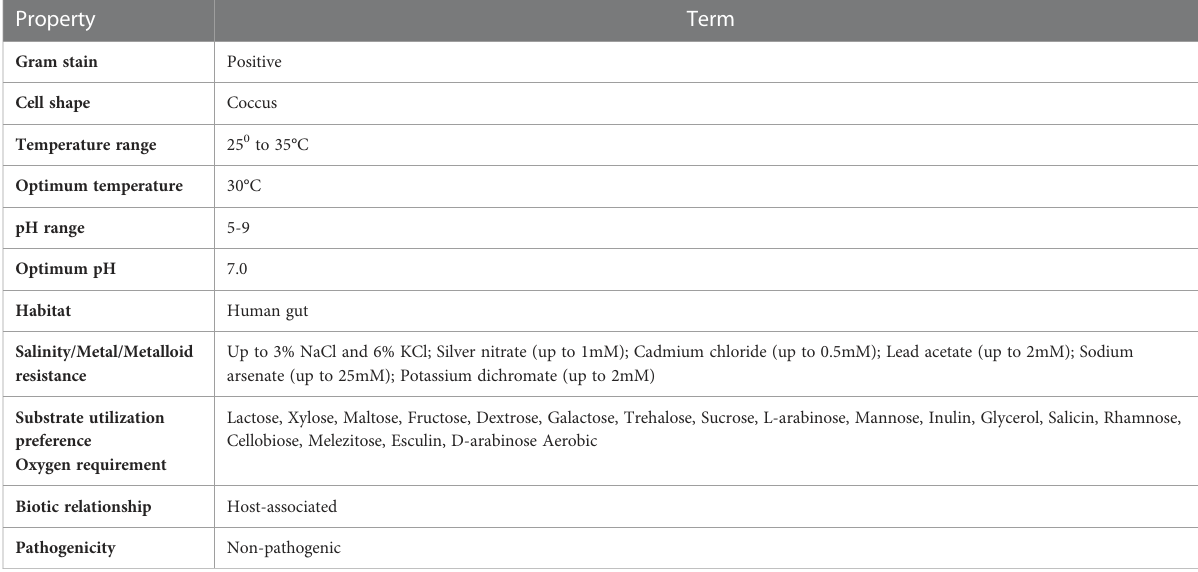
annotation identi fi ed 3,996 coding genes and 53 tRNAs and 3 rRNAs in the genome of Cellulomonas sp. HM71 (Figure 2 ; Table 2). Genome characterization identi fi ed 34 features associated with antibiotic resistance, 30 protein features associated with oxidative stress tolerance, and 6 features associated with heat tolerance (Supplementary Table S4). A number of antibiotic and metal/metalloid resistance gene clusters were also observed in its genome (Supplementary Tables S4, S5). Additionally, CAZymes annotation with HMMER resulted in a total of 30 CAZymes clusters (Supplementary Table S6). No pathogenic islands/genes were determined within the genome of the microbial isolate.